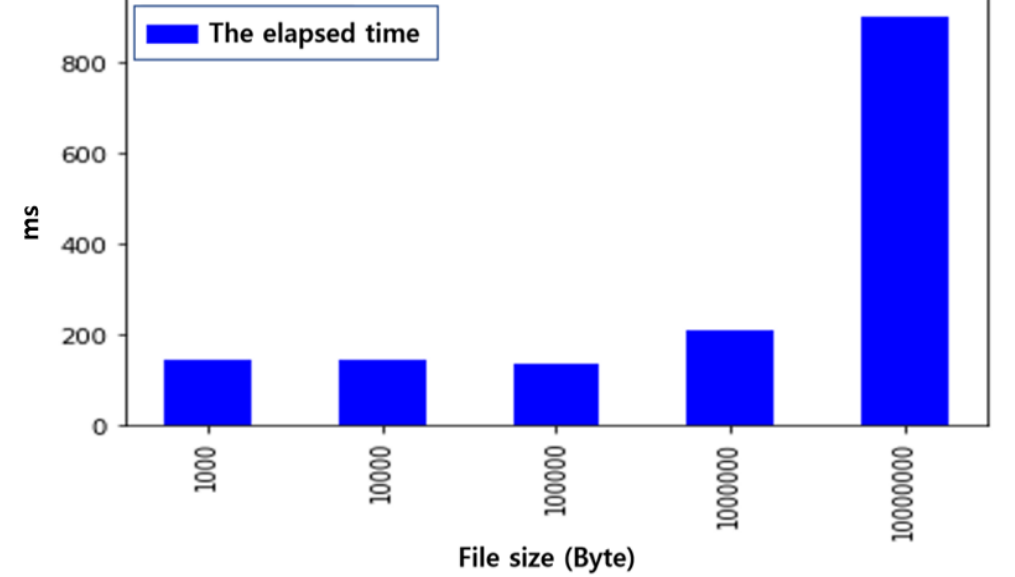
Figure 12. Evaluation of the elapsed time writing to IPFS.